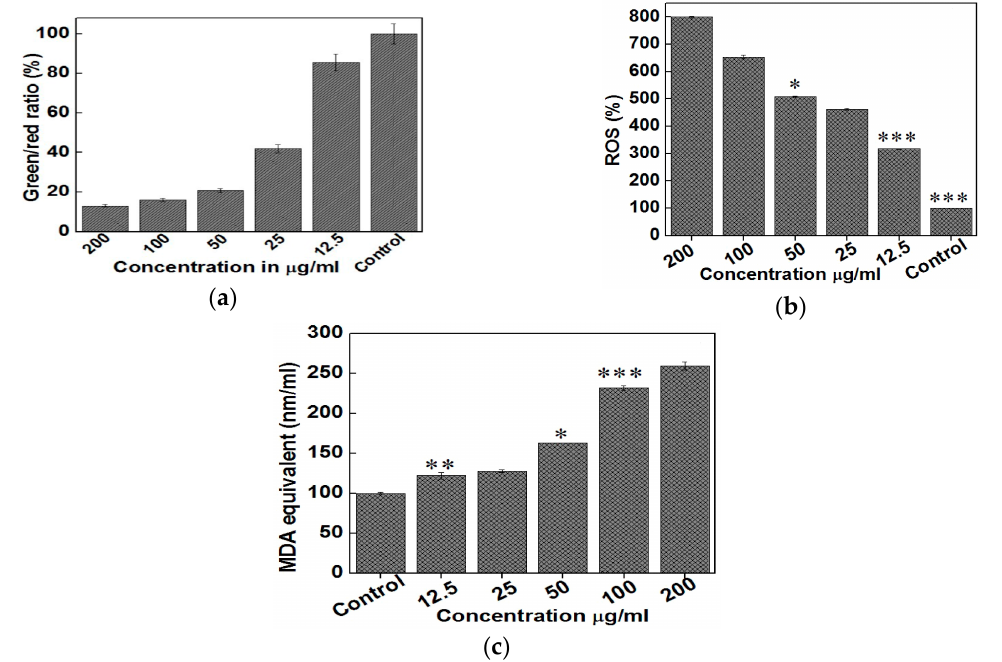
Figure 35. ( a ) Change in fluorescence intensity of green/red ratio of live/dead assay, ( b ) ROS and ( c ) MDA levels of E.coli treated with different Cu 5 /ZnO concentrations. The data were expressed as the mean ± SD (standard deviation) for three independent experiments ( n = 3). p < 0.05 (*), 0.001 (**) and 0.0001 (***) were measured significant as compared to control. Reproduced from [102] with permission of the American Chemical Society.